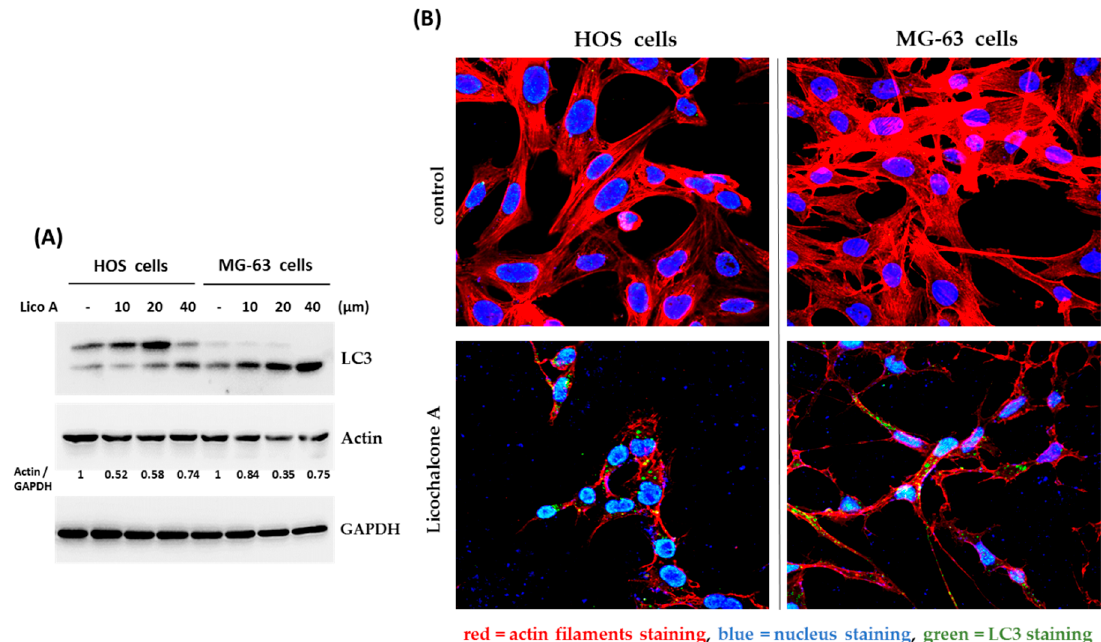
Figure 5. Autophagy is induced in Licochalcone A -treated osteosarcoma cells. HOS cells and MG-63 cells were treated with indicated concentrations of Licochalcone A (Lico A) for 24 h. The treated cells were analyzed by Western blotting using the indicated antibodies ( A ), or were immunostained with LC3 antibody for autophagy formation (green color), phalloidin-iFluor 594 reagent for labeling actin filaments (red color), and 4 ′ ,6-diamidino-2-phenylindole (DAPI) for labeling nucleus (blue color) ( B ). The levels of actin were quantified and are shown below the blot in Western blotting.